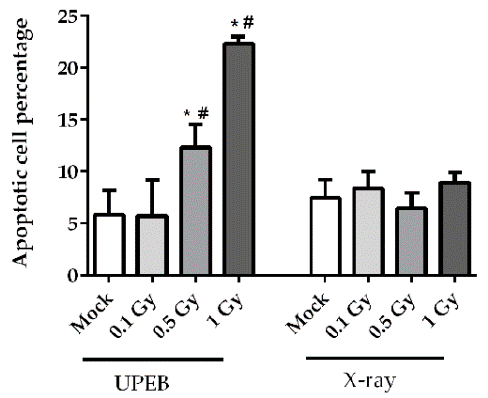
Figure 3. The percentage of apoptotic MRC5 cells 24 h after UPEB and X-ray irradiation. * p < 0.05 in comparison to control (mock-irradiated cells). # p < 0.05 in comparison to corresponding doses of X-ray irradiation. Data represent the mean ± standard error of the results of three independent experiments.